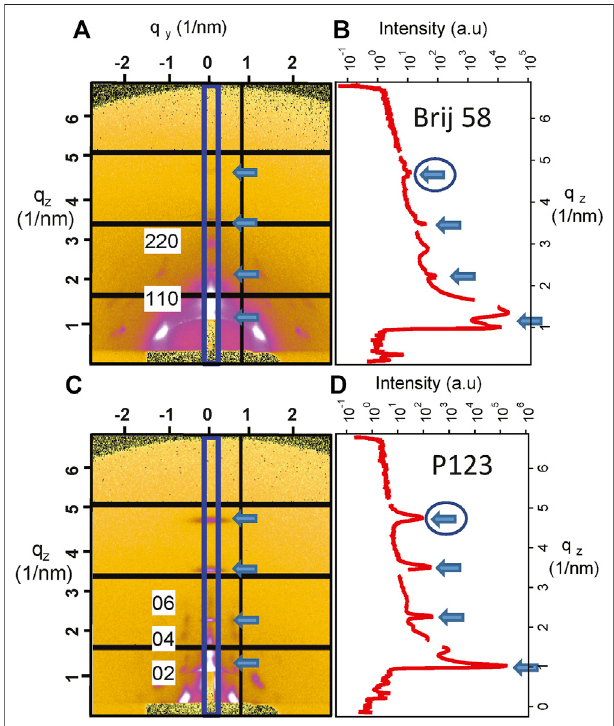
FIGURE 2 | (A) GISAXS image and (B) I – q z patterns corresponding to the vertical cut evidenced by the rectangle for mesoporous silica prepared with Brij 58 and calcined after POPC deposition. The distorted (110)-oriented body centered cubic structure is evident and partially indexed along the q z direction. (C) Image at the detector and (D) I – q z patterns corresponding to the vertical cut evidenced by the rectangle for mesoporous silica prepared with P123 and calcined after POPC deposition. The distorted hexagonal structureisevidentandindexedalongtheq z direction.Thearrowsindicatethe contribution of POPC, and the circled ones de fi ne the peaks that were used for the determination of the POPC phase